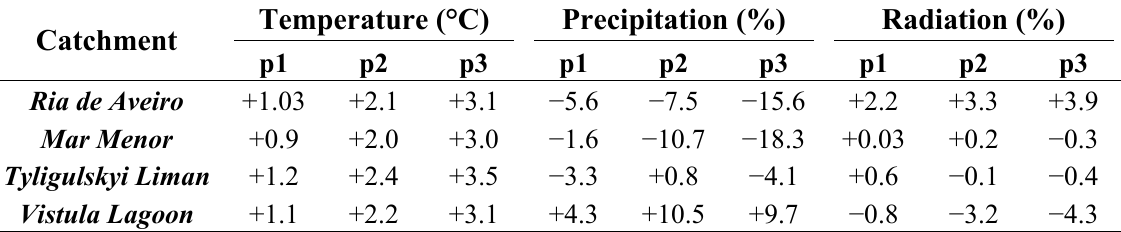
Table 5. Annual climate change signals of the three future periods p1, p2, and p3 related to the reference period p0 for the parameters air temperature, precipitation and solar radiation averaged over 15 selected ENSEMBLES climate scenarios per lagoon